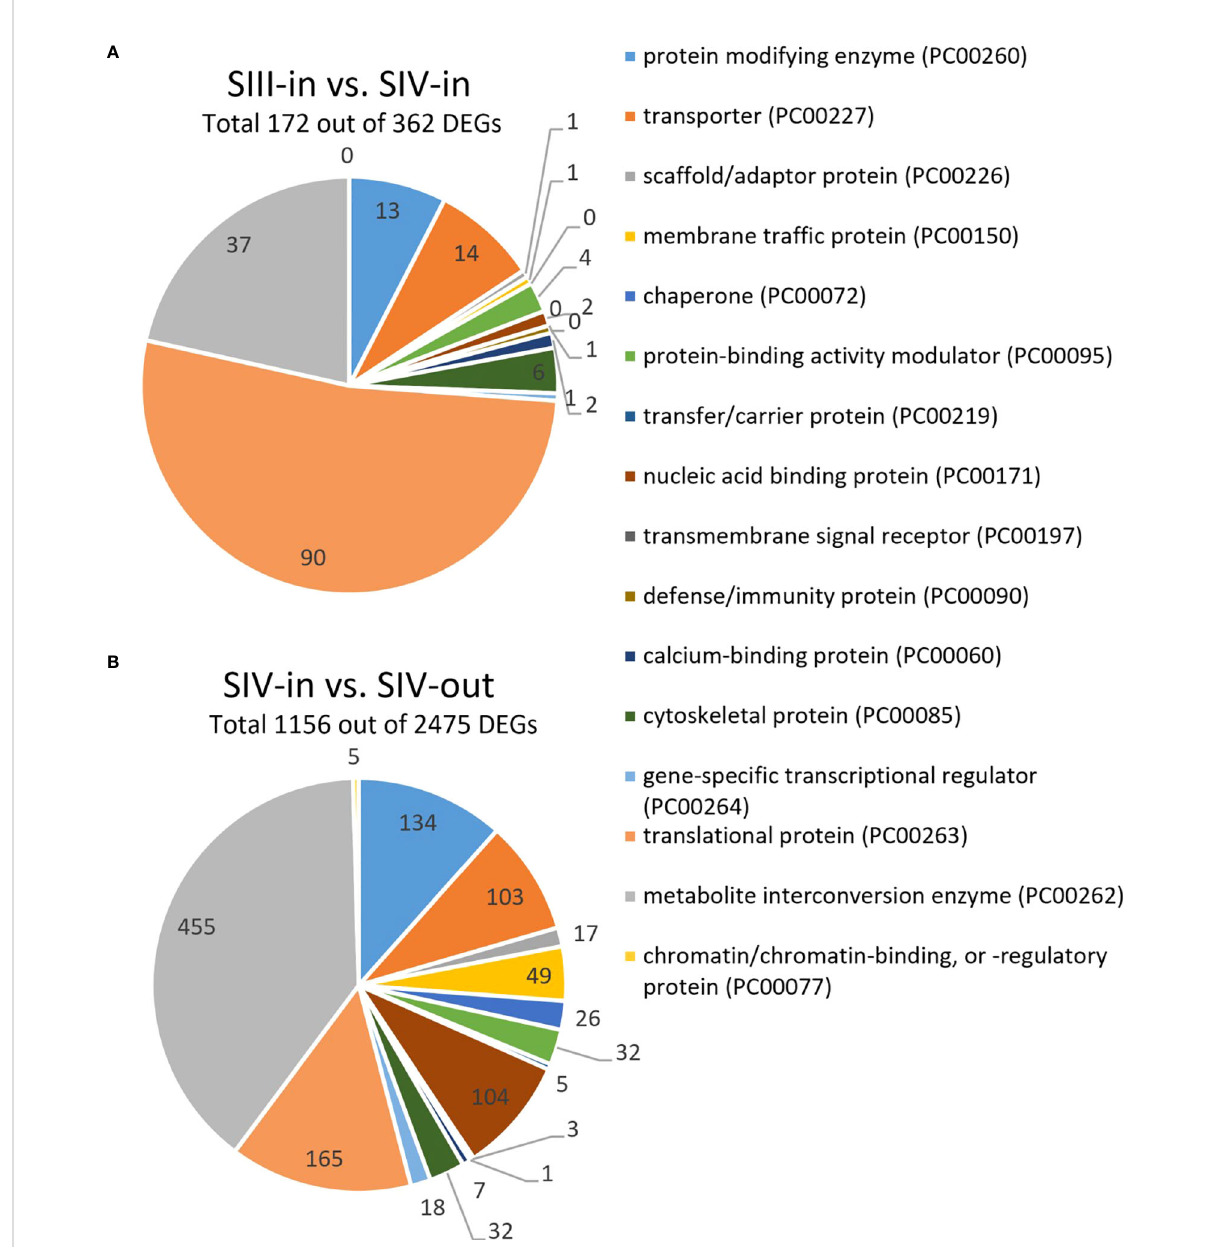
FIGURE 3 Most notable differences in GO annotations for DEGs from transcriptomic analysis of dahlia fl orets based on annotation to Arabidopsis thaliana ( p adjust. < 0.05) (A) inner fl orets of Stage III fl owers (SIII-in) vs. inner fl orets of Stage IV fl owers (SIV-i) and (B) inner fl orets of Stage IV fl owers (SIV-i) vs. outer fl orets of Stage IV fl owers (IV-out). GO annotation based on http://www.pantherdb.org; Mi et al.